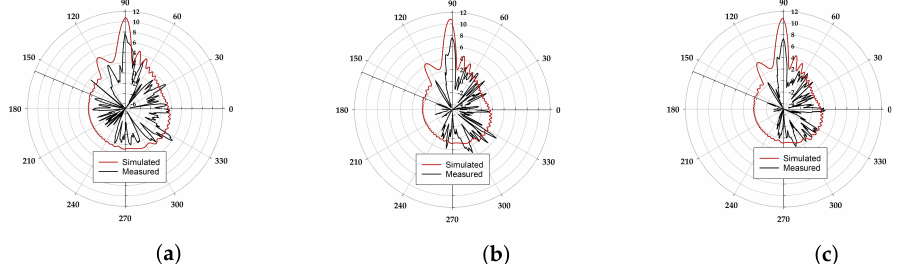
Figure 10. Simulated and measured radiation pattern. ( a ) 28.5 GHz, ( b ) 29 GHz, and ( c ) 29.5